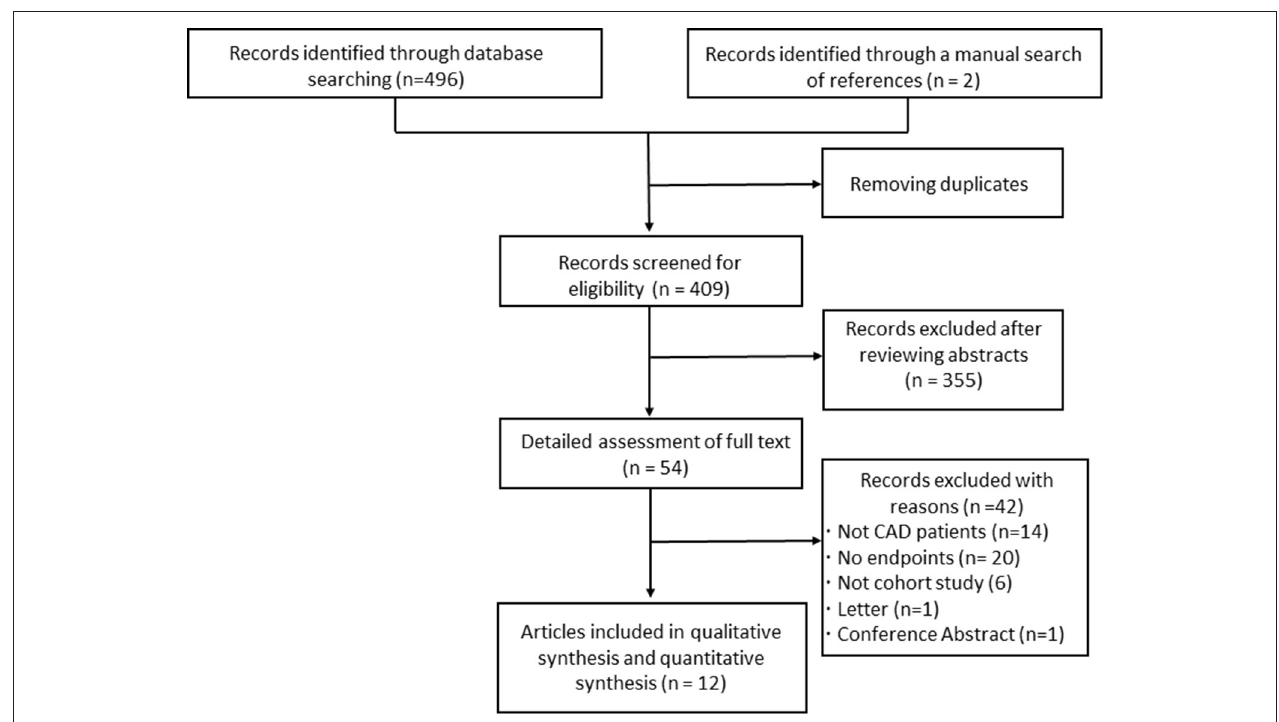
FIGURE 1 | Flowchart of the study selection process and